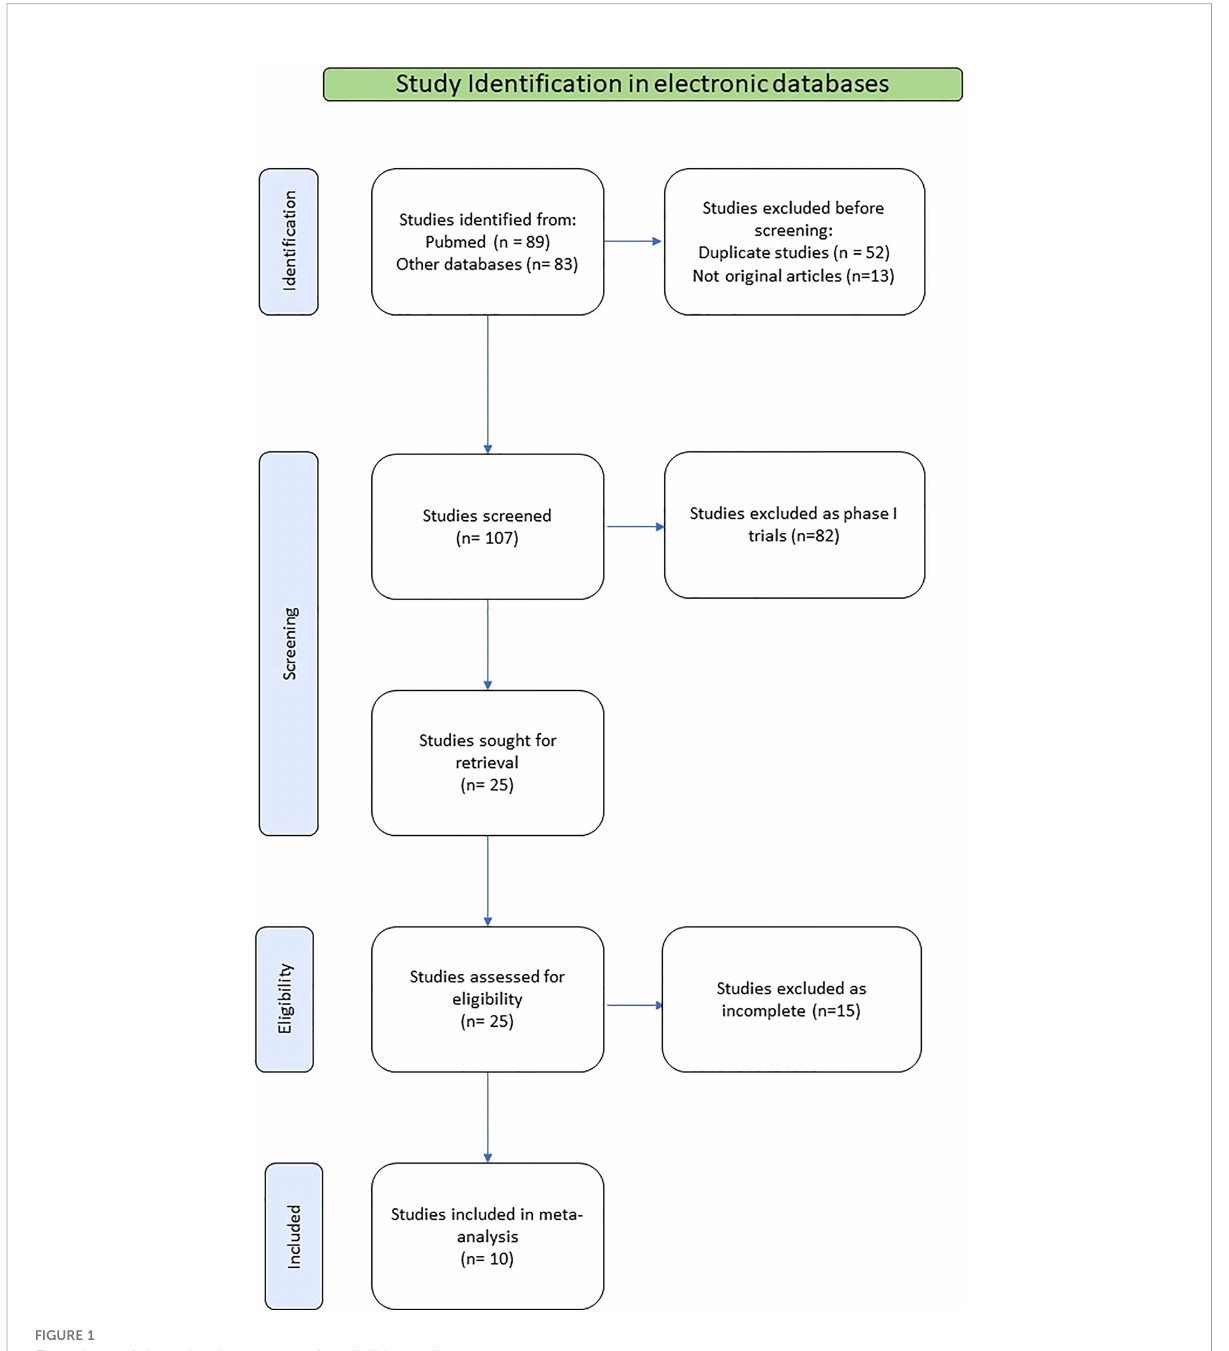
FIGURE 1 Flowchart of the selection process for eligible